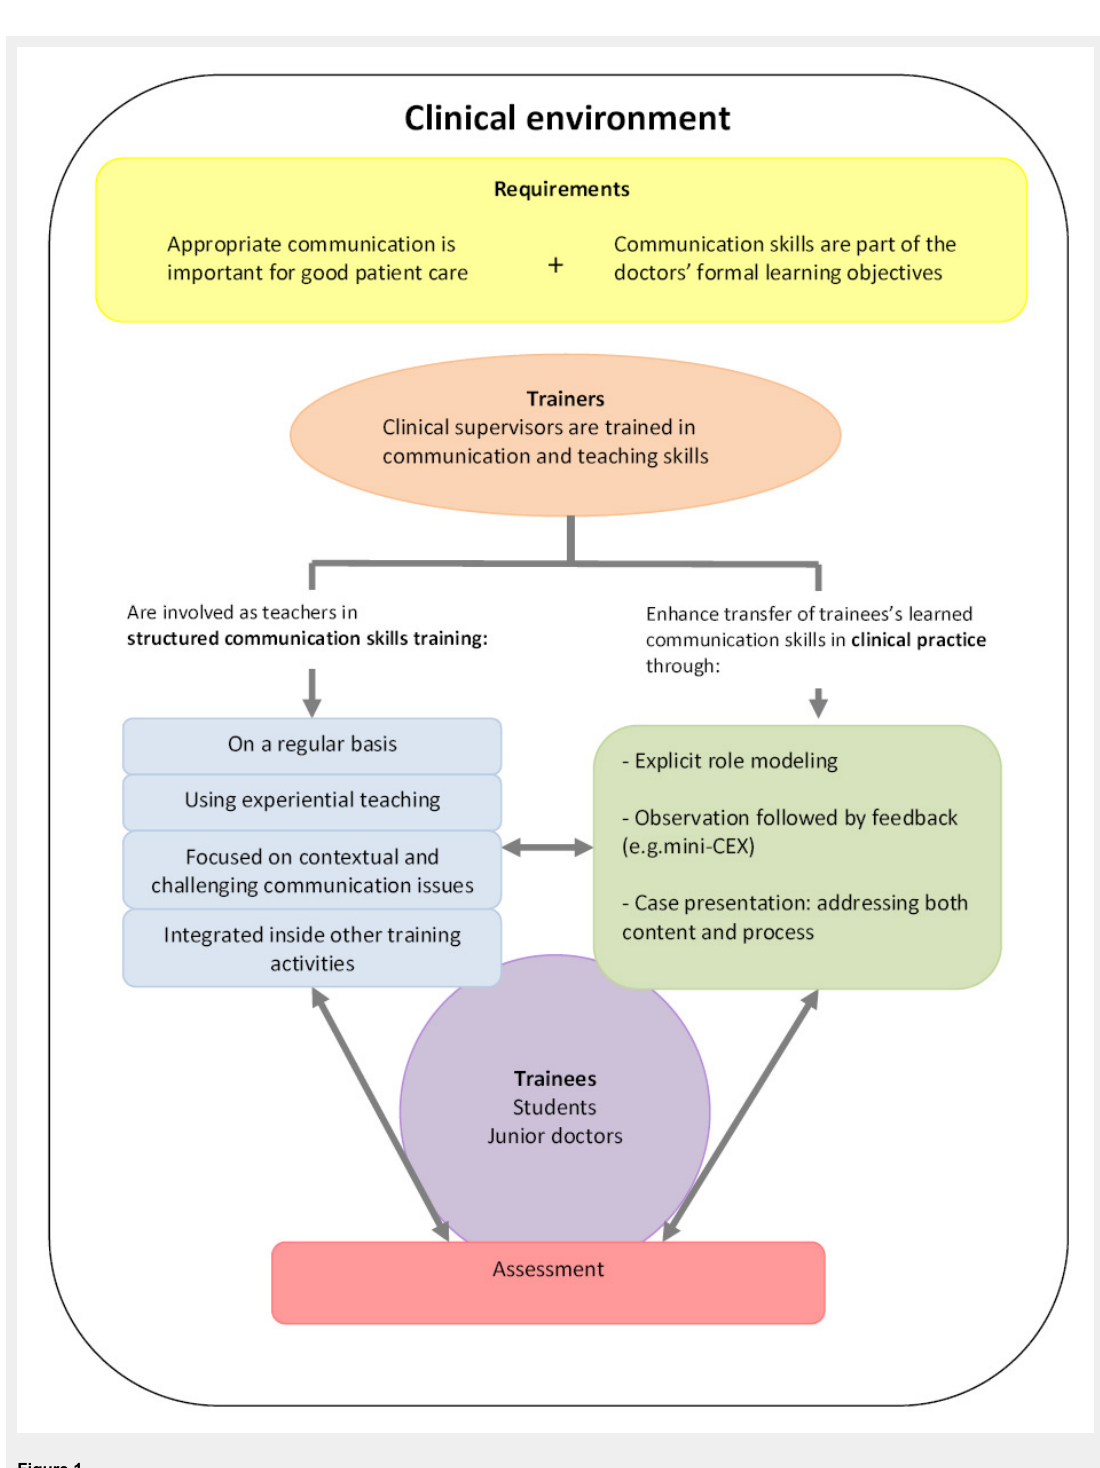
Figure 1 Dynamic model of communication skills training and teaching in the clinical